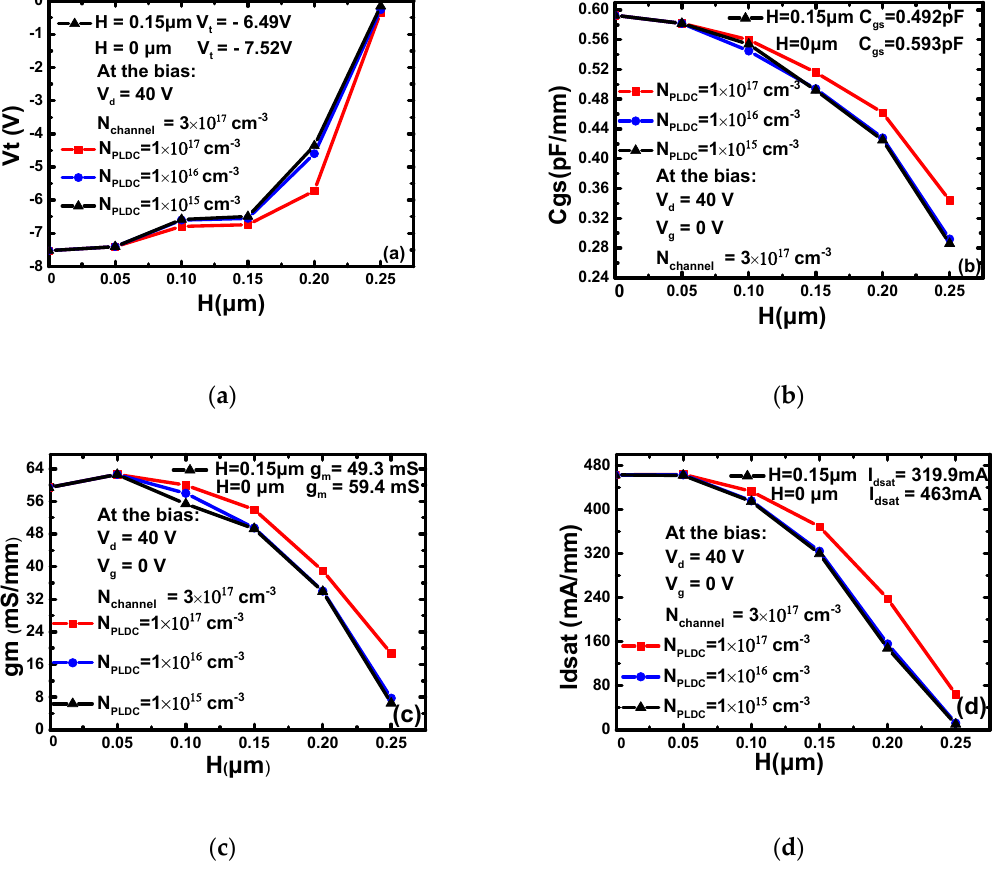
Figure 2. The effect of N PLDC and H on the device parameters: ( a ) V t - N PLDC and H , ( b ) C gs - N PLDC and H , (c) g m - N PLDC and H , (d) I dsat - N PLDC and H. H , ( c ) g m - N PLDC and H , ( d ) I dsat - N PLDC and H